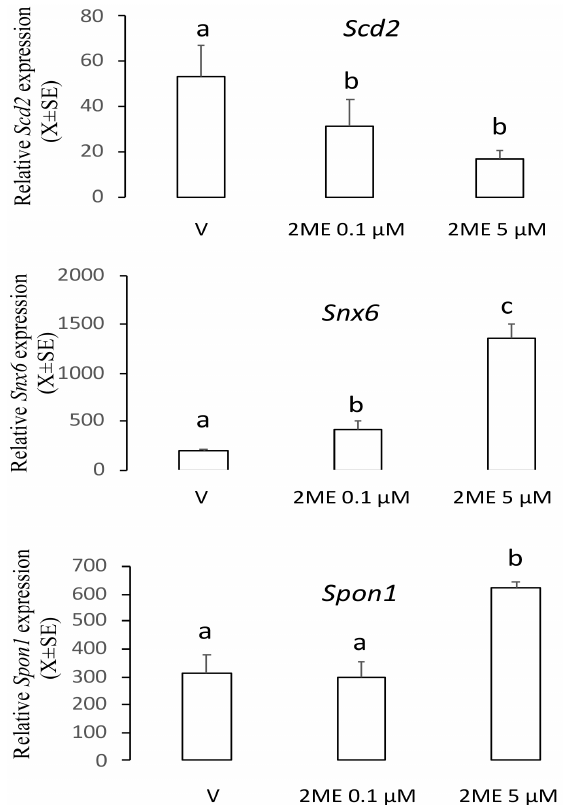
Figure 1. Levels of the transcripts Scd2 , Snx6 , or Spon1 in the Ishikawa cells treated with a non-apoptotic (0.1 µ M) or apoptotic (5 µ M) concentration of 2-methoxyestradiol (2ME). Cells were incubated with 2ME for 12 h and then processed by real-time PCR. This experiment consisted of 5 replicates. a (cid:44) b (cid:44) c, p < 0.05. Note that Spon1 was increased only at the apoptotic concentration of 2ME.